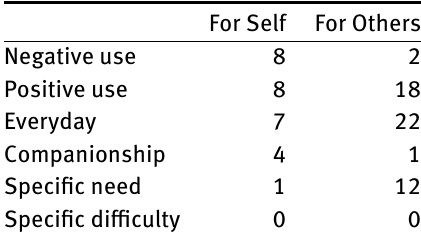
Table 11: Co-occurrences of Scenario Capability by Category. For